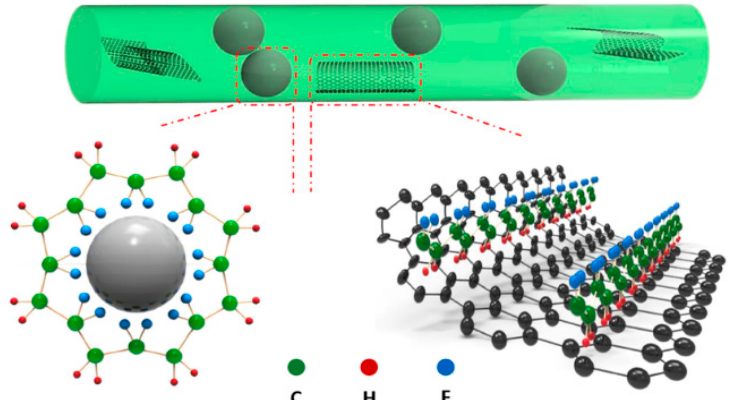
Figure 22. Image of the β -phase facilitated by nanographene.